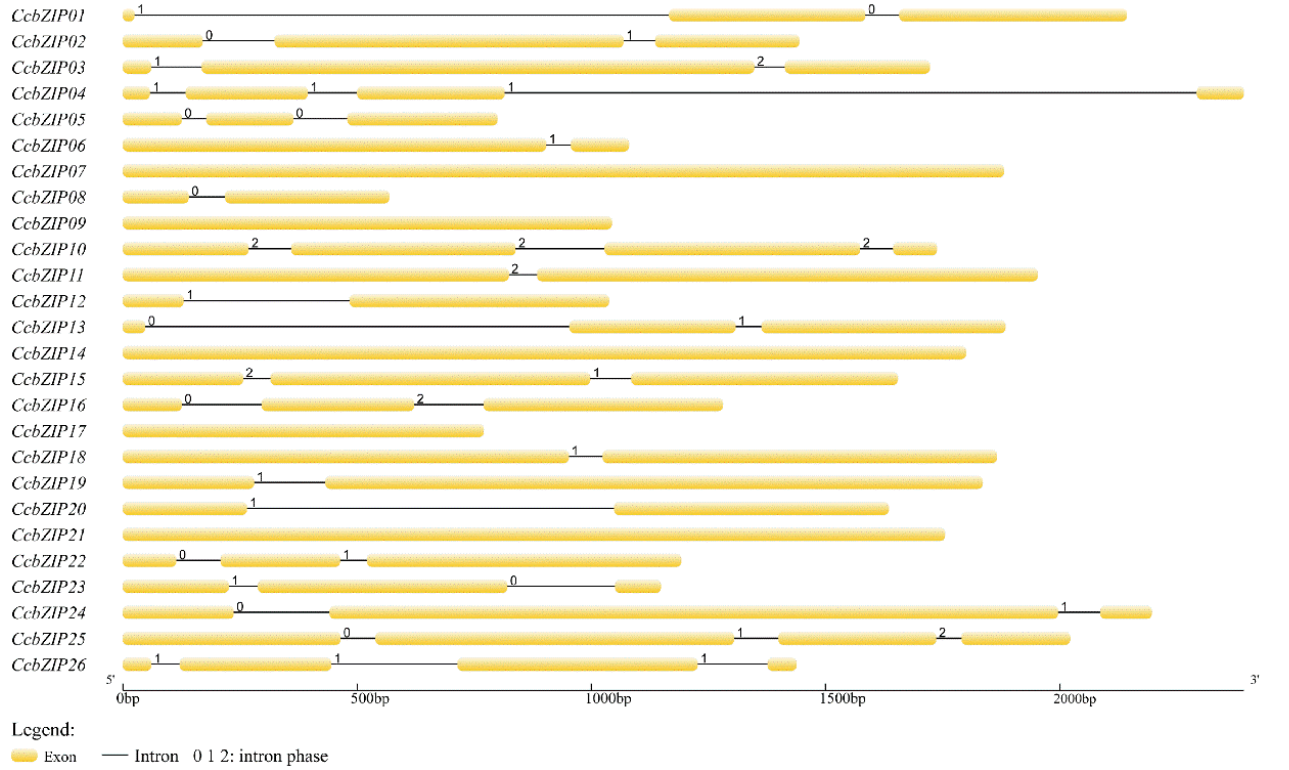
Figure 2. The gene structures of CcbZIPs . Arrangement of introns and exons were displayed by GSDS version 2.0. Exons are drawn to scale in the yellow boxes. The black lines connecting the two exons represent introns. The numbers 0, 1, and 2 represent the splicing phase of intron. Phase 0 means intron splicing site is between codons, while phase 1 and phase 2 mean the intron splicing site is located after the first and second nucleotide of a codon, respectively.